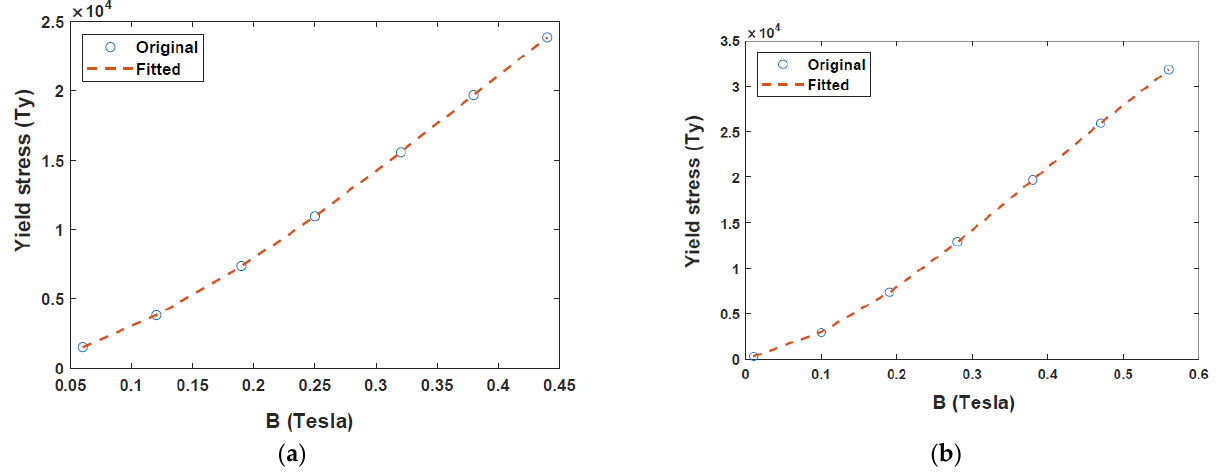
Figure 4. Polynomial curve fitting for variation of yield stress with magnetic flux density of MRF- 132DG: ( a ) Annular channel; ( b ) Radial channel.